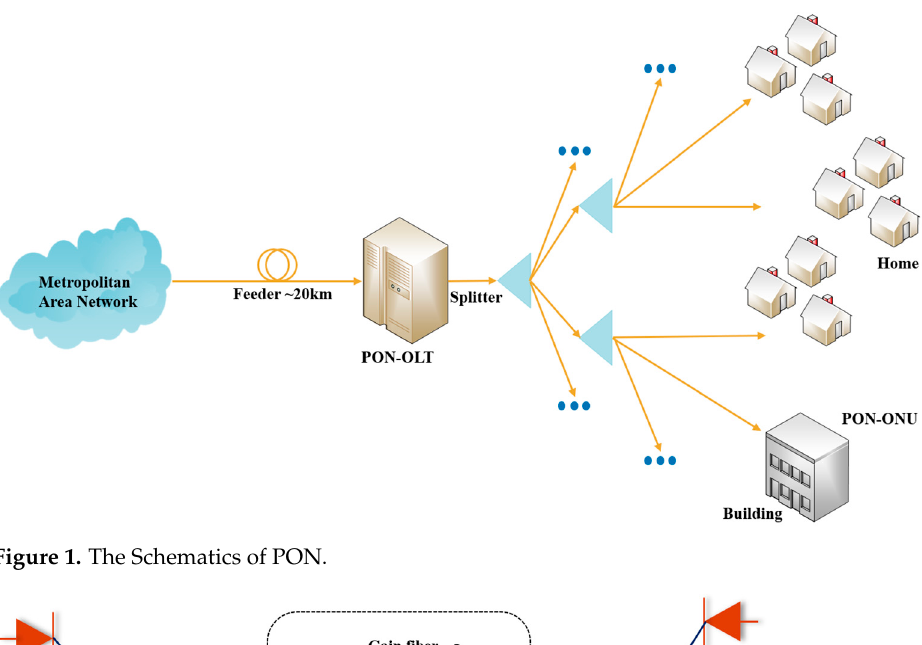
Figure 1. The Schematics of PON.